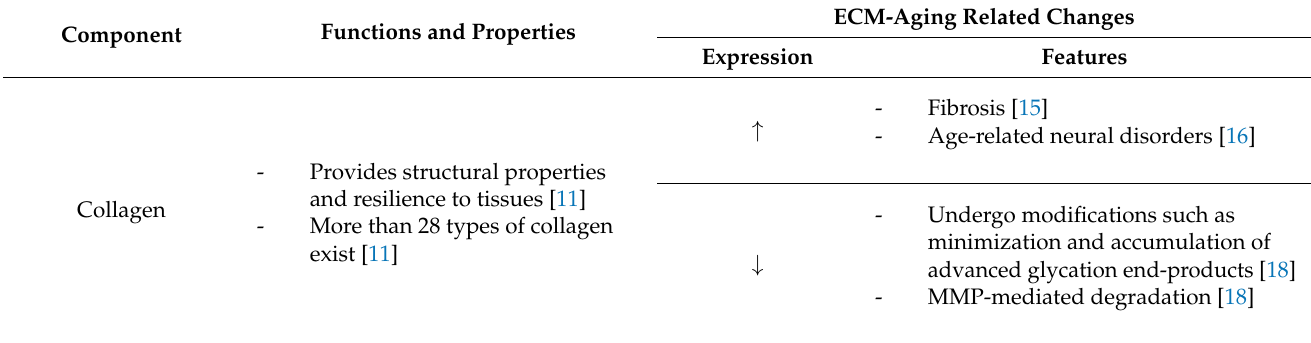
Table 1. Features of senescence-related extracellular matrix (ECM)